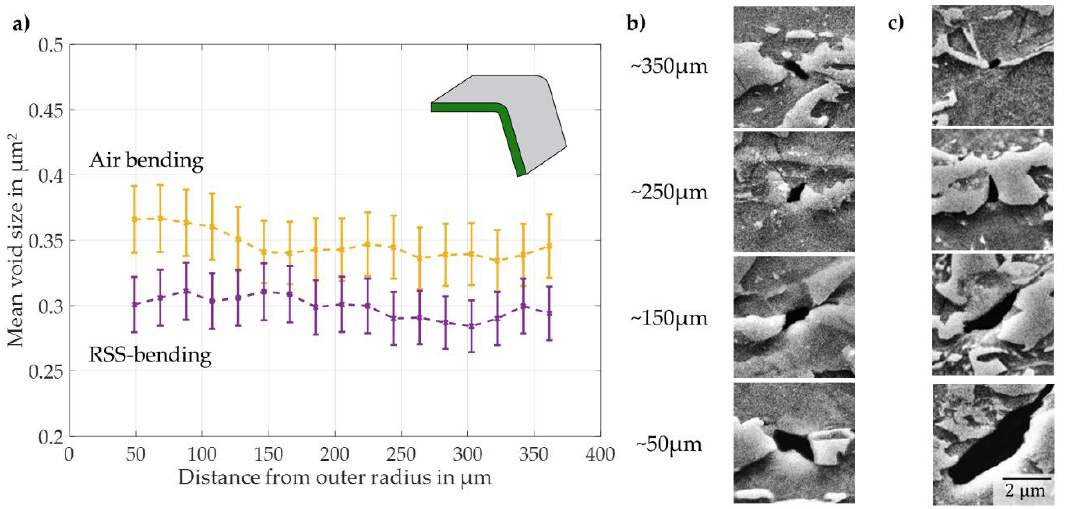
Figure 11. ( a ) Mean void size in the in-plane samples for air-bent and RSS-bent samples; representative void morphologies at various distances from the outer radius for ( b ) RSS bending and ( c ) air